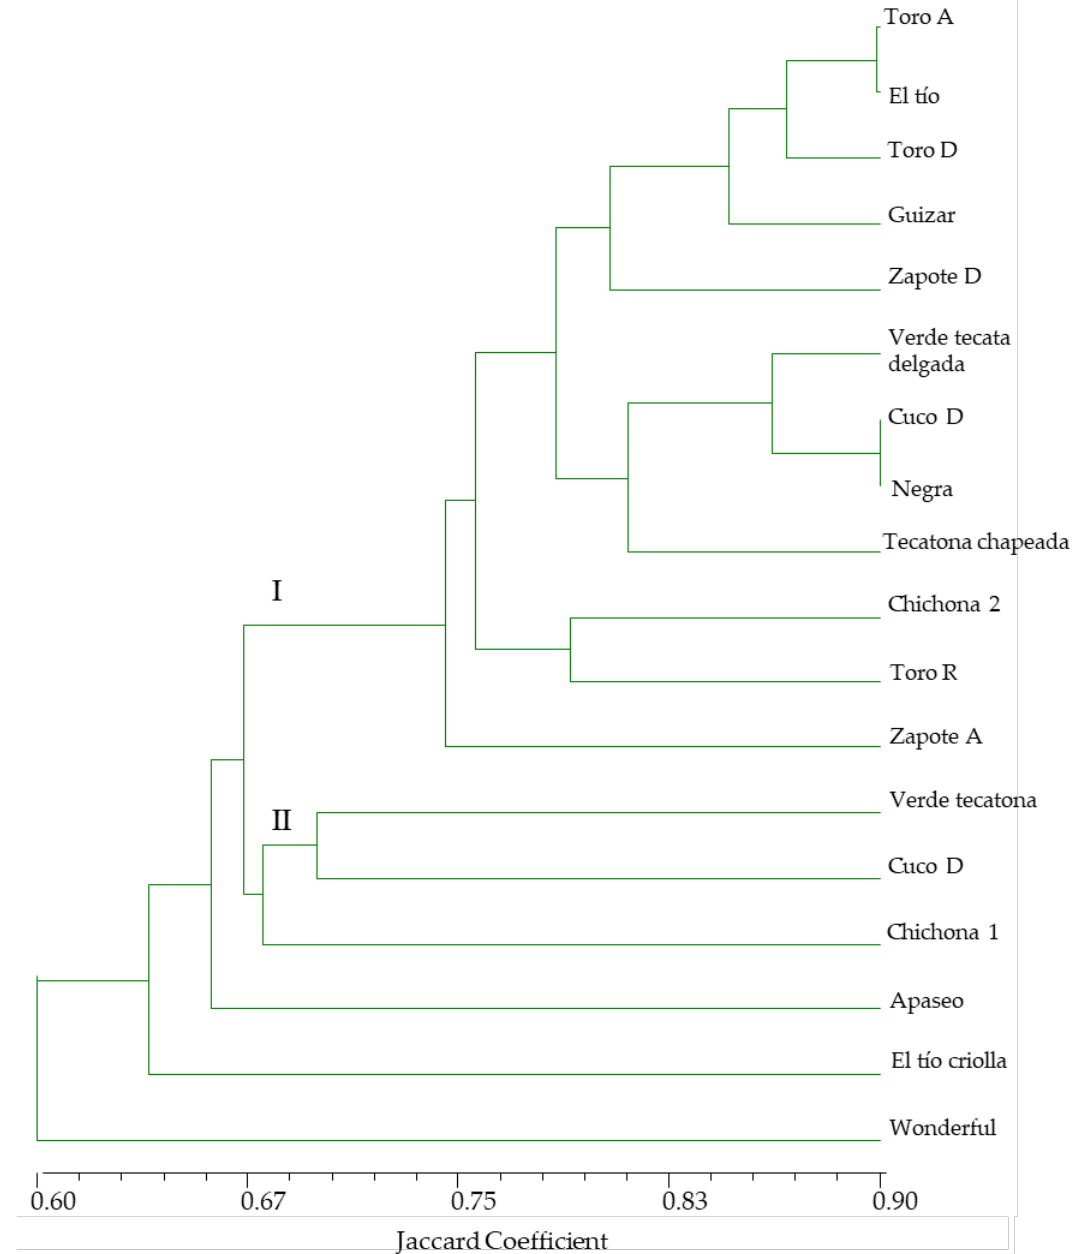
Figure 4. UPGMA dendrogram (Jaccard’s coefficient) of 18 pomegranate genotypes from southern Jalisco using AFLP markers (r = 0.88). I and II: the two main groups formed from the analysis.